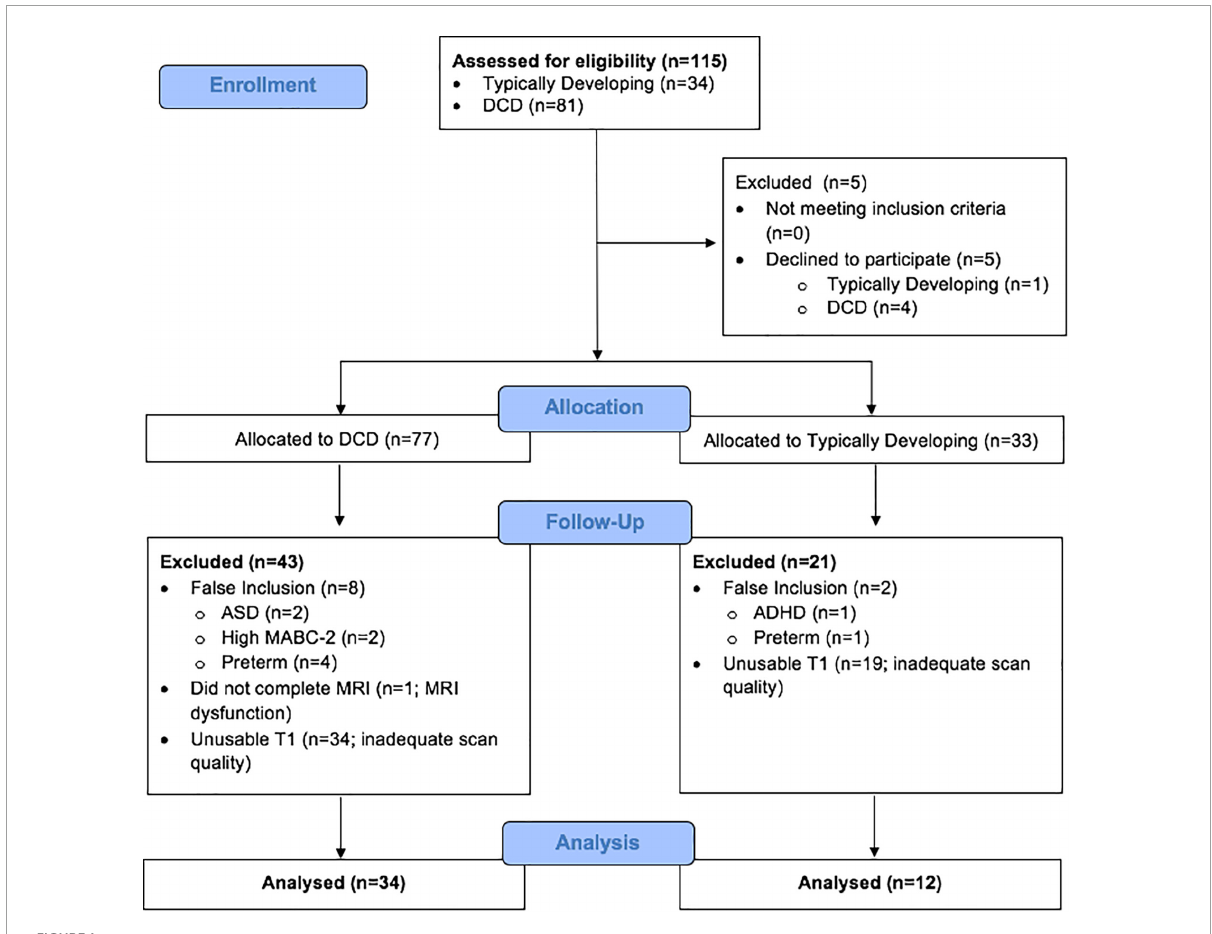
FIGURE1 Flow diagram of participant inclusion/exclusion for voxel-based morphometry analysis.